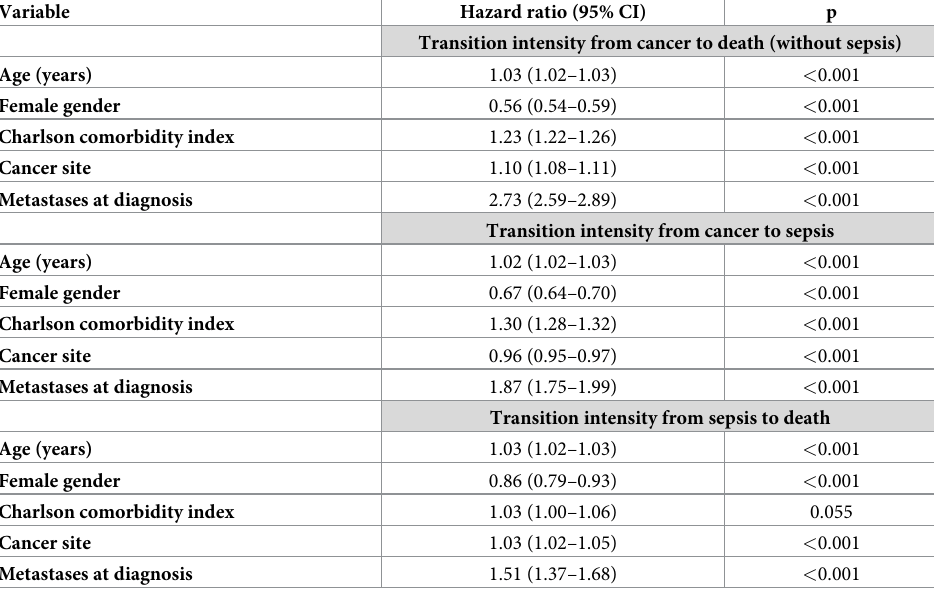
Table 4. Summary of the multistate Cox semi-markov model assessing the effect of baseline characteristics on the transition between cancer, sepsis and death.